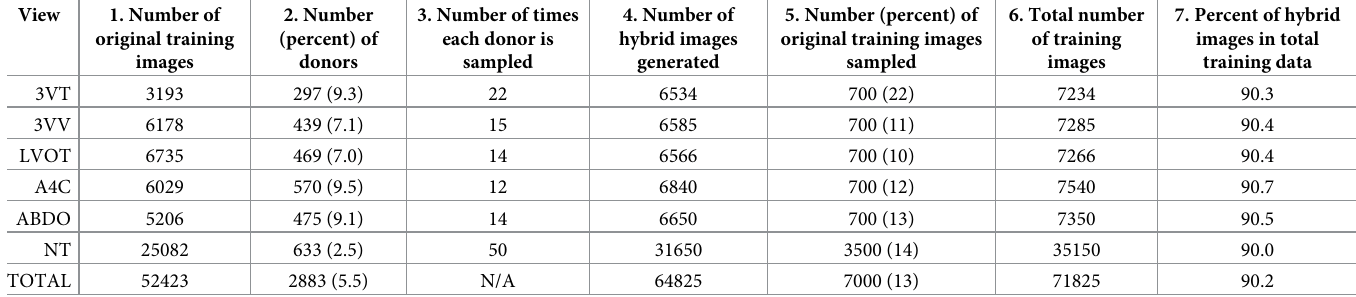
Table 1. Distribution of training data with 90 percent hybrid images.